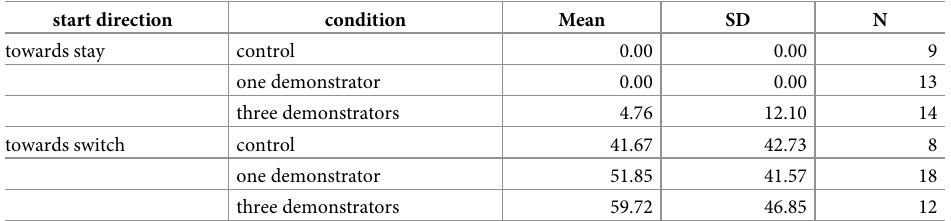
Table 1. Descriptive statistics for the percentage of switch responses across